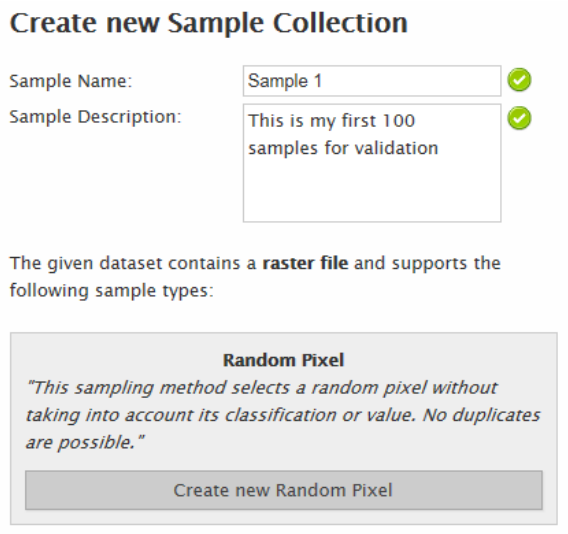
Figure 7. Setting up a randomly selected validation sample